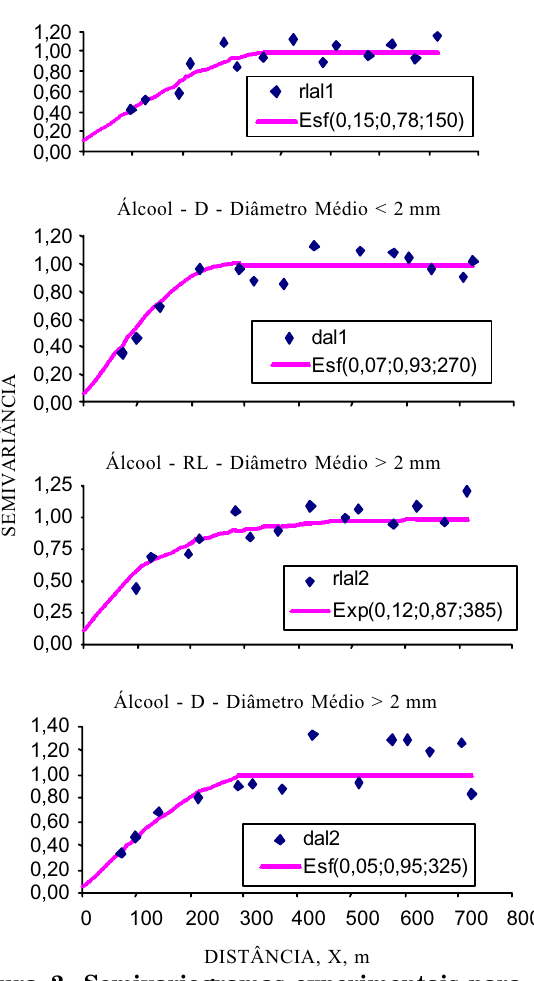
Figura 2. Semivariogramas experimentais para o maior tamanho de agregado - R dimensão da massa fractal D no pré-tratamento com álcool. Modelos: esférico (Esf) e exponencial (Exp)